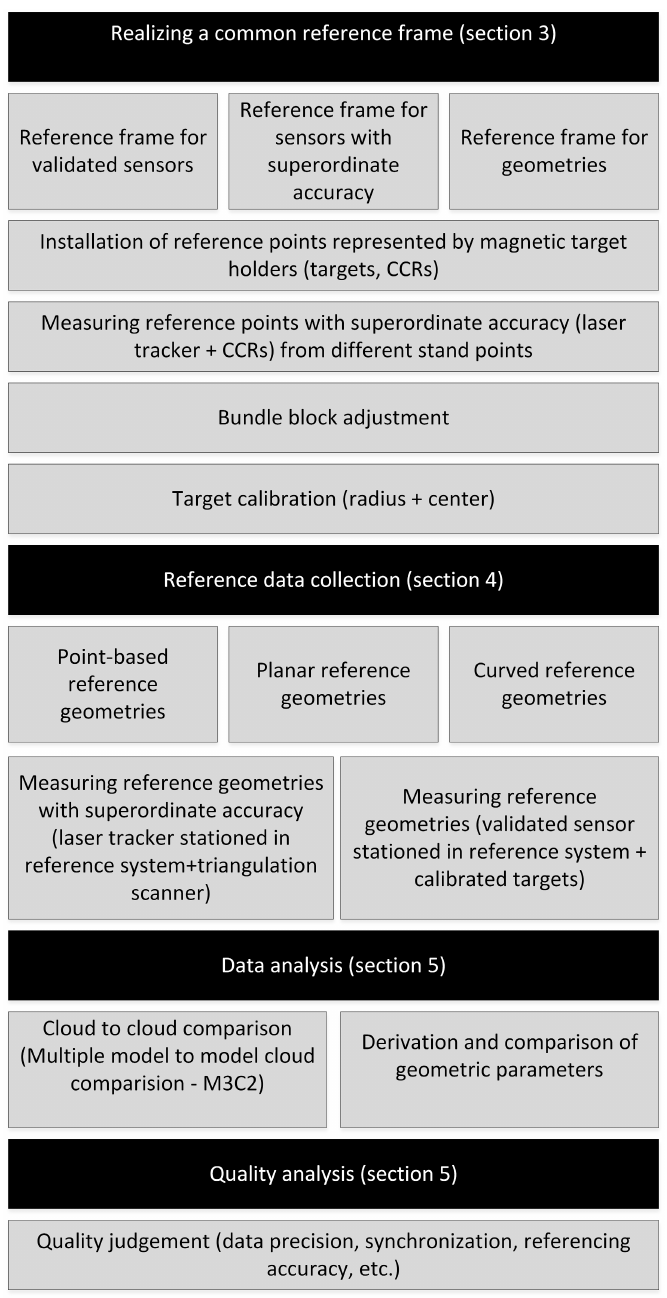
Figure 6. Validation process (workflow).